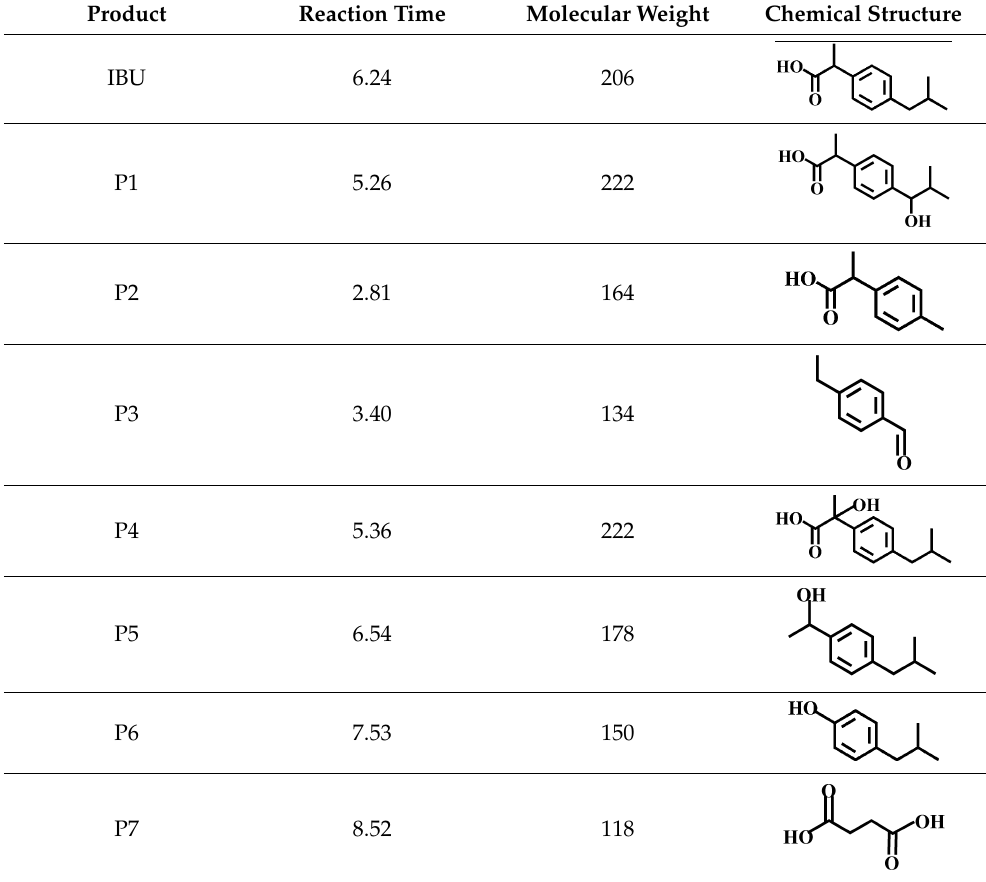
Figure 7. Degradation pathways of IBU in the EC/Fe 3+ /PDS system.